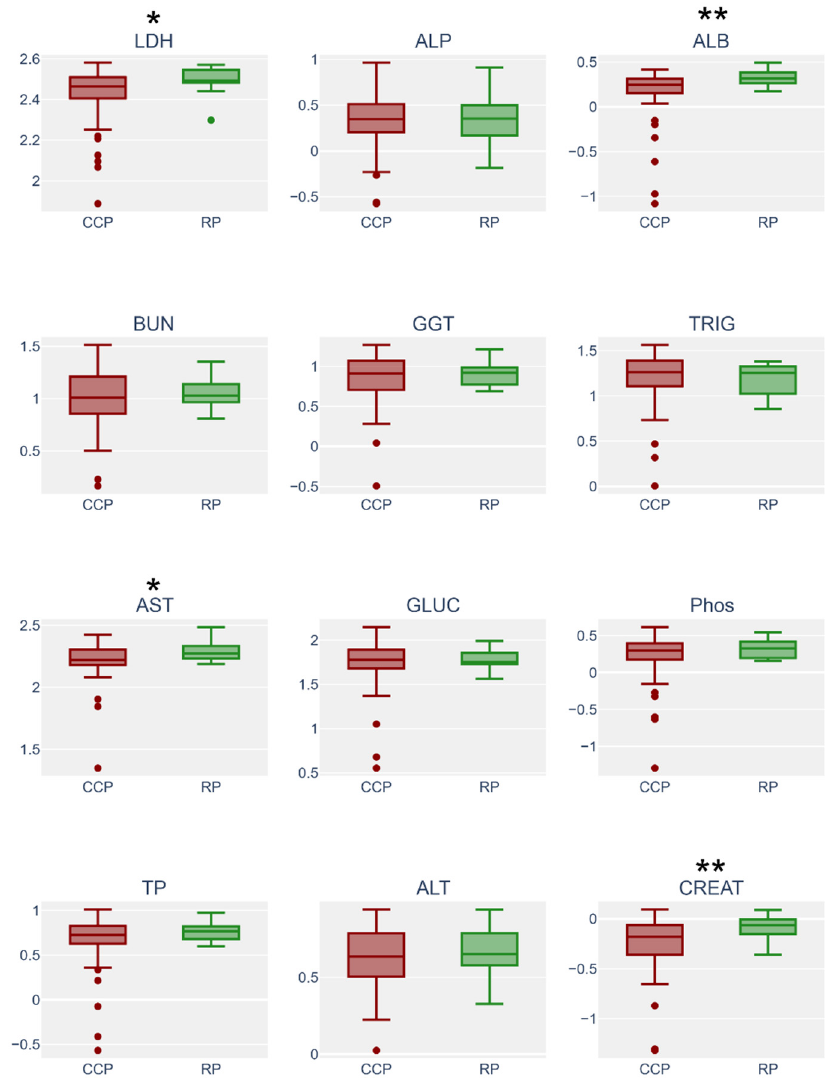
Figure 1. Box plots of blood plasma data conveying the differences between blood during the CCP ( n = 68) and the RP ( n = 15). Asterisks represent statistical significance ( p value ≤ 0.1 = *; p value ≤ 0.05 = **). LDH: lactate dehydrogenase ( p value 0.06), U/L; ALP: alkaline phosphatase, U/L; ALB: albumin ( p value 0.04), g/dL; BUN: blood urea nitrogen, mg/dL; GGT: gamma-glutamyl transferase, U/L; mg/dL; TRIG: triglycerides, mg/dL; AST: aspartate amino transferase ( p value 0.09), U/L; TP: total protein, g/dL; GLUC: glucose, mg/dL; Phos: phosphate, mg/dL; ALT: alanine transaminase, U/L; CREAT: creatinine ( p value